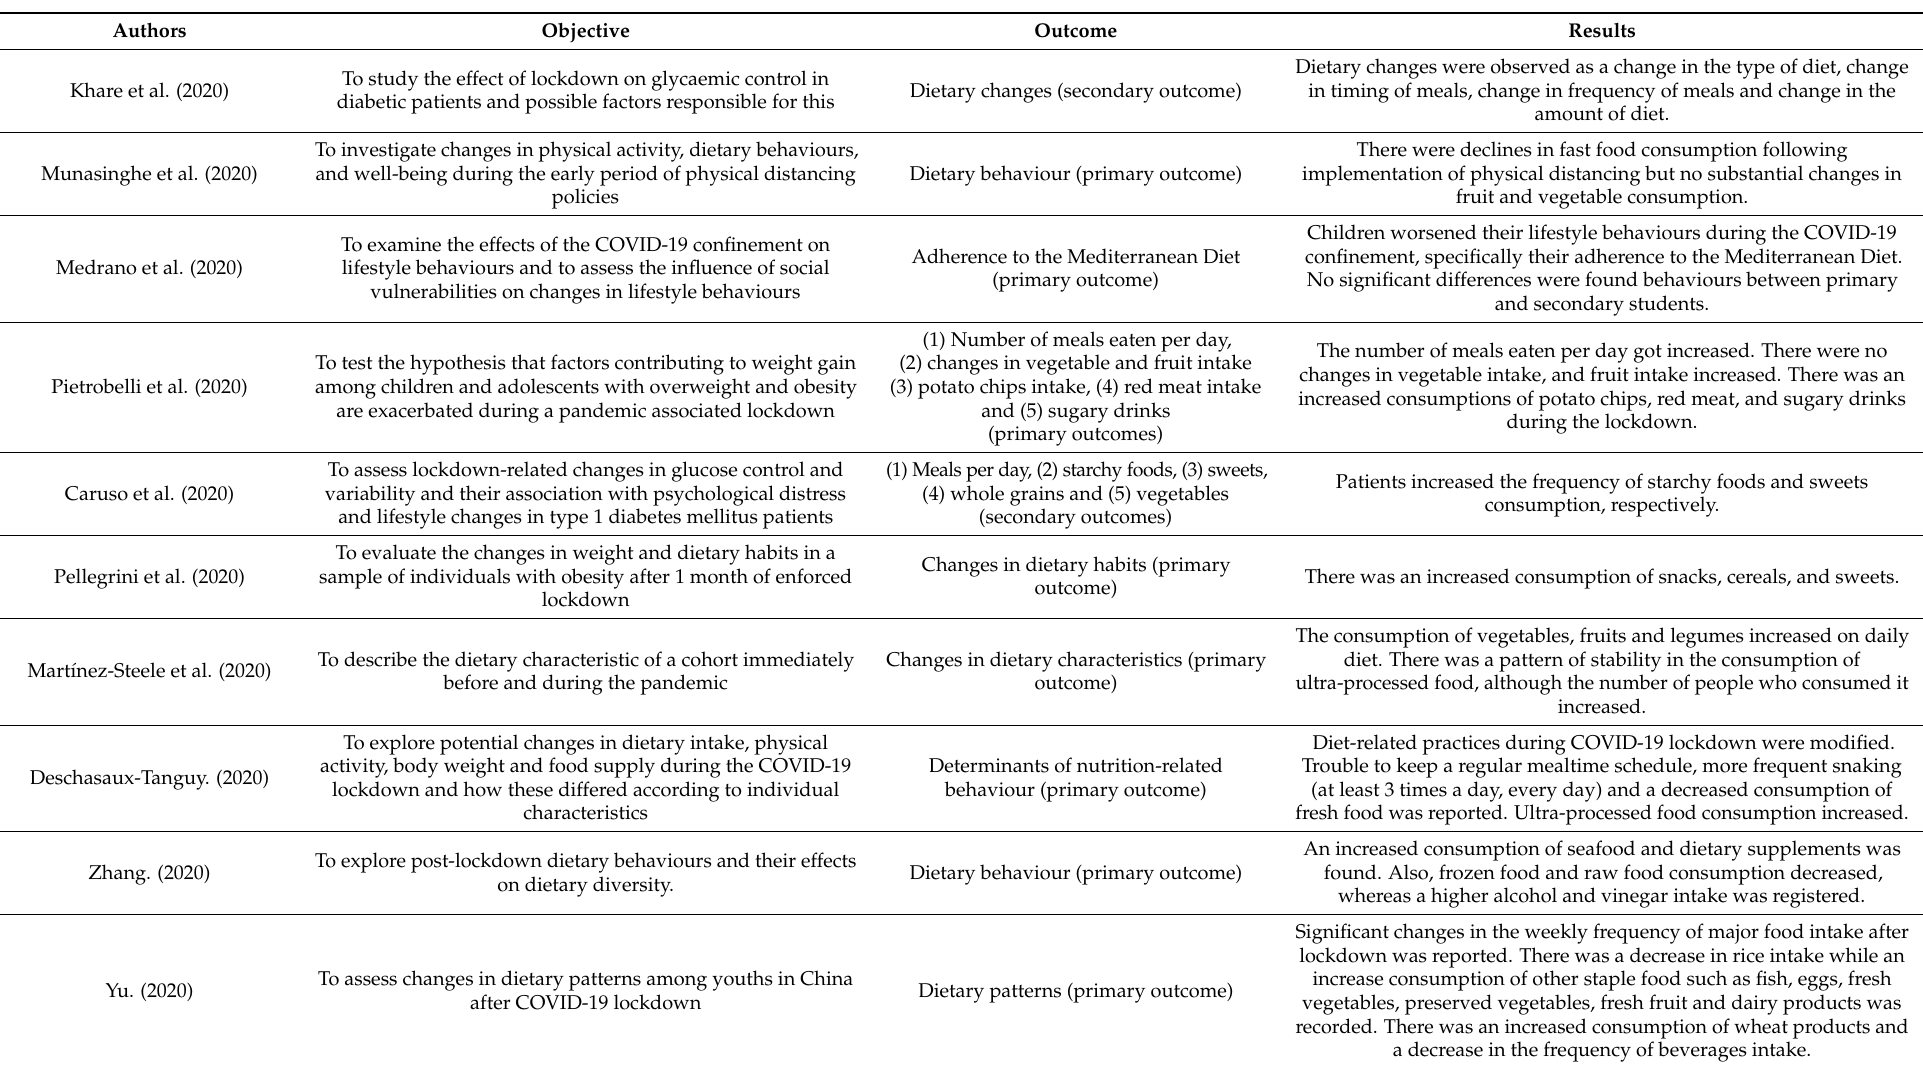
Table 4. Objective, outcomes and results of the included